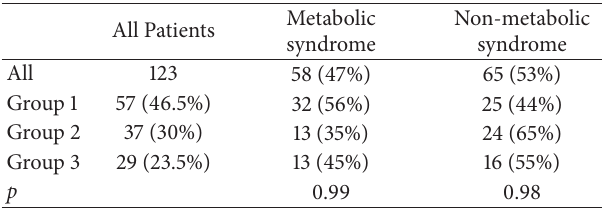
Table 1: Breastfeeding groups distributions of children with and without metabolic